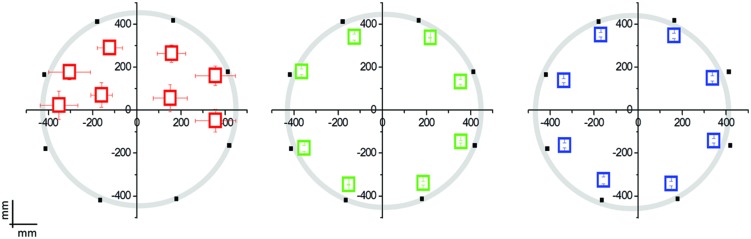
Mean localization bias in early blind (EB) individuals (N = 12; in red), late blind (LB) individuals (N = 8; in green), and blindfolded sighted controls (N = 20; in blue) relative to the hand pointing task following the moving sound from the origin to one of the eight position on the circle. The black dots indicate the eight possible end-point positions. The origin (0,0) corresponds to the nose of the participant. EB participants performed far worse than LB individuals or blindfolded controls, presenting a deficit in the lower side positions.